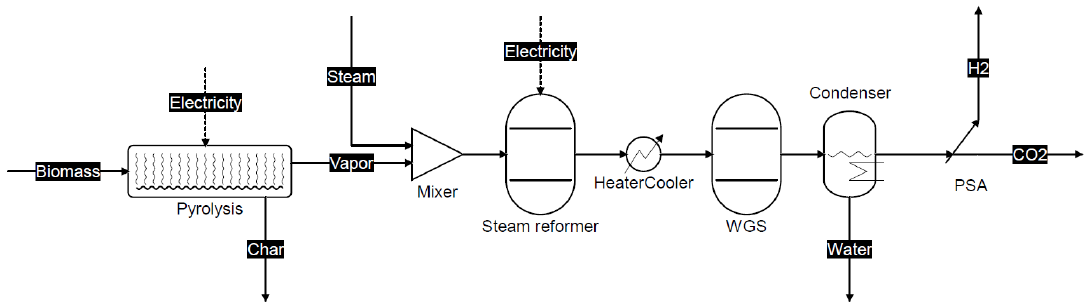
Figure 1. Scheme 1: production of H 2 and biocarbon.